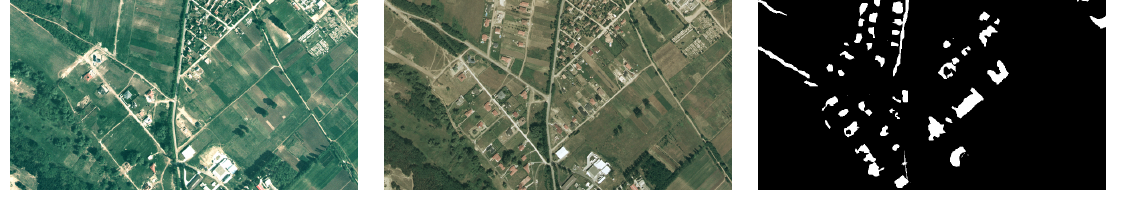
( f ) Figure 14. The results of different methods on SZADA/1. ( a ) Image one. ( b ) Image two. ( c ) Grounth truth. ( d ) Result using FC-Siam-diff. ( e ) Result using the pseudo-siamese capsule network. ( f ) Result using the change capsule